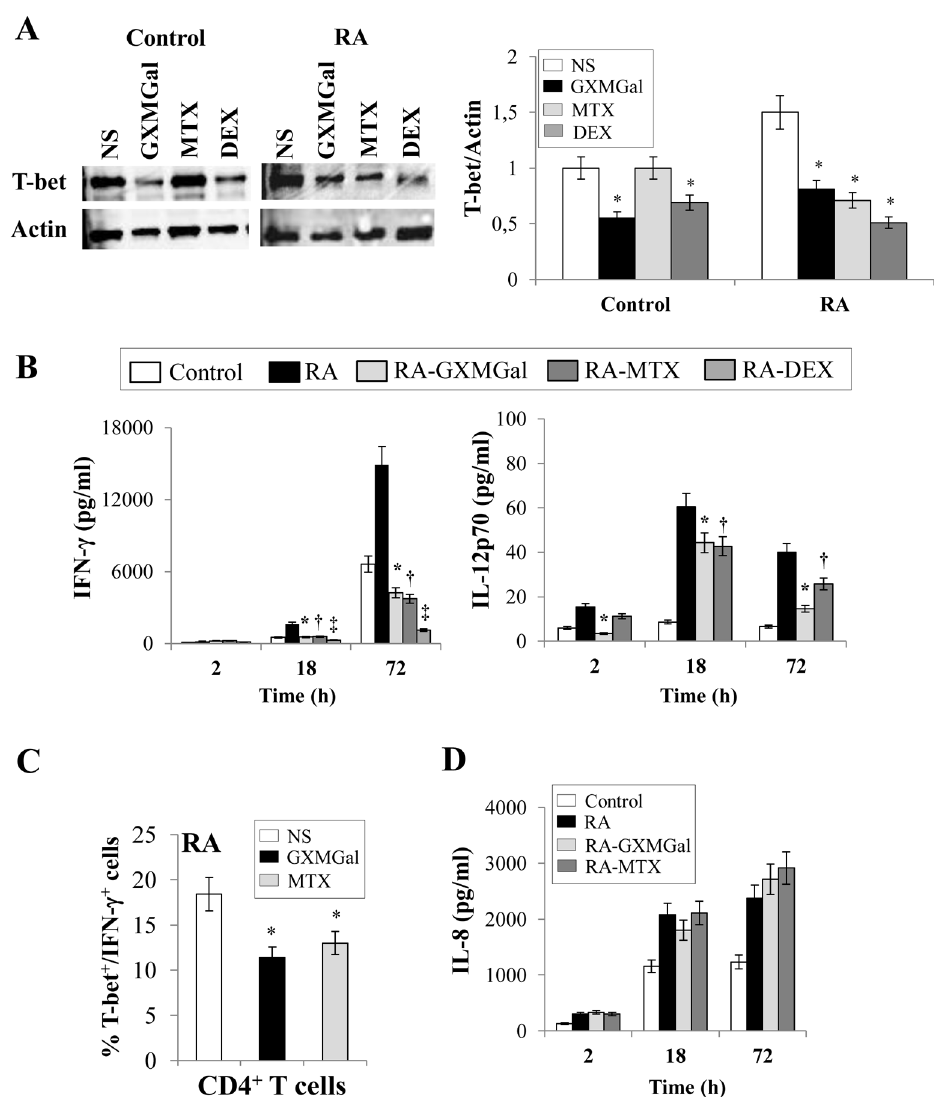
Figure 5. GXMGal effect on Th1 response. Activated PBMC ( A , B and D ) (5 6 10 6 /ml) from Control and RA were incubated for 20 min, 2, 18 and 72 h in the presence or absence (NS) of GXMGal (10 m g/ml), MTX (10 ng/ml) or DEX (10 nM). After 20 min of incubation, cell lysates were analyzed by western blotting. Membranes were incubated with Ab to T-bet. Actin was used as an internal loading control. Normalization was shown as mean 6 SEM of five independent experiments. *, p , 0.05 (triplicate samples of 5 different Control and RA; treated vs untreated cells) ( A ). Culture supernatants were collected after 2, 18 and 72 h to test IFN- c , IL-12p70 ( B ) and IL-8 ( D ) levels by specific ELISA assays. *, p , 0.05 (triplicate samples of 7 different Control and RA; RA GXMGal-treated vs untreated cells); { , p , 0.05 (triplicate samples of 7 different Control and RA; RA MTX-treated vs untreated cells); ` , p , 0.05 (triplicate samples of 7 different Control and RA; RA DEX-treated vs untreated cells). Activated purified CD4 + T cells (1 6 10 6 /ml) ( C ) from RA were stimulated as above described and intracellular stained for T-bet and IFN- c . The percentage of T-bet + /IFN- c + CD4 + T cells from RA after 18 h of GXMGal or MTX treatment was shown as mean 6 SEM of five independent experiments. *, p , 0.05 (triplicate samples of five different RA; treated vs untreated